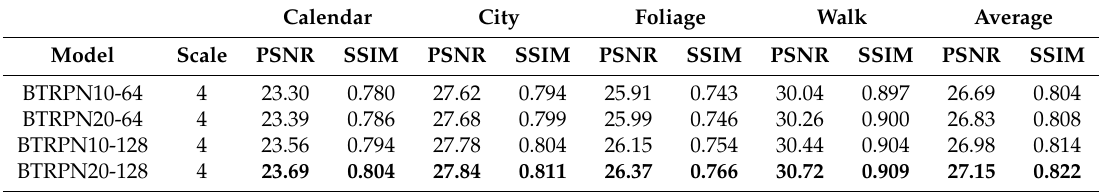
Table 2. The comparison of different BTRPN models on the VID4 dataset for 4 × VSR.